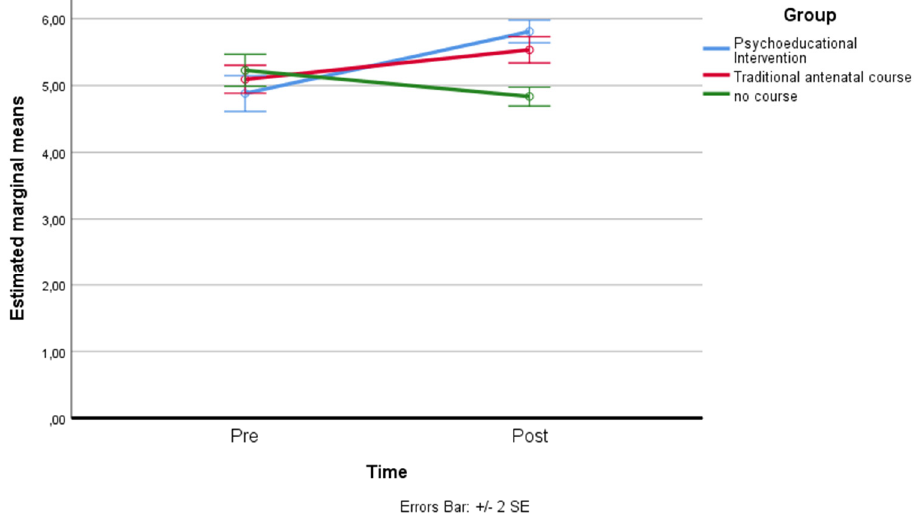
Figure 8. Estimated marginal means of present focus.